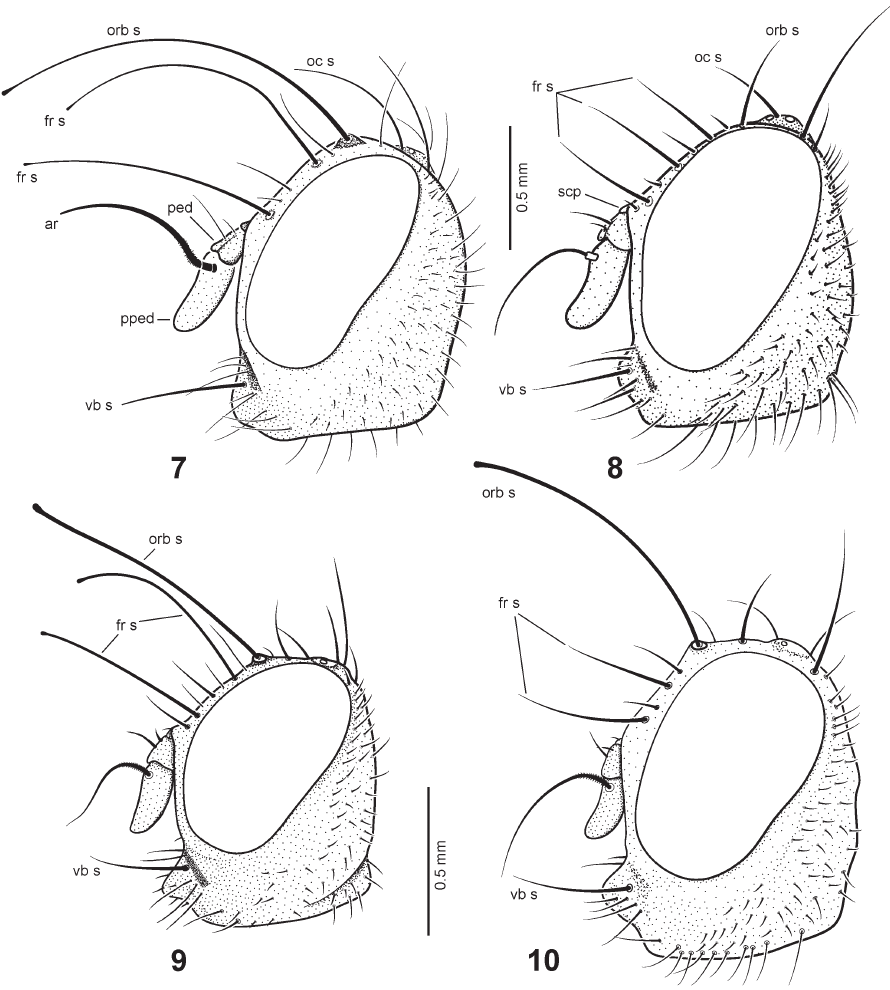
Figures 7–10. Coenosia spp. heads, lateral view 7 C. flagelliseta sp. nov. ♂ 8 C. flagelliseta sp. nov. ♀ 9 C. macrotriseta ♂ 10 C. globuliseta ♂ . Figs 9, 10 modified (Muller and Miller 2013, figs 2A,B). Abbrevia- tions: ar – arista; fr s – frontal seta; oc s – ocellar seta; orb s – orbital seta; ped – pedicel; pped – postpedicel; scp – scape; vb s – vibrissal seta.